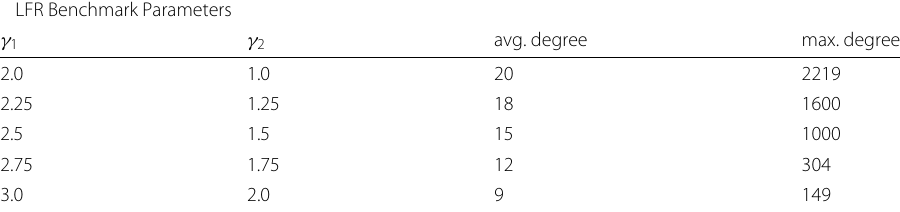
Table 2 Parameters used for the LFR benchmark graphs LFR Benchmark